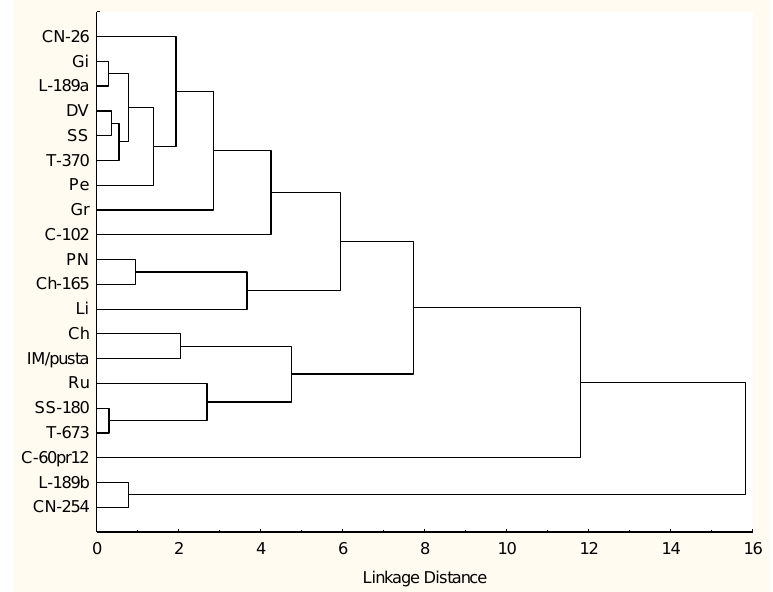
Figure 1. Dendrogram of tomato landraces for quality traits.